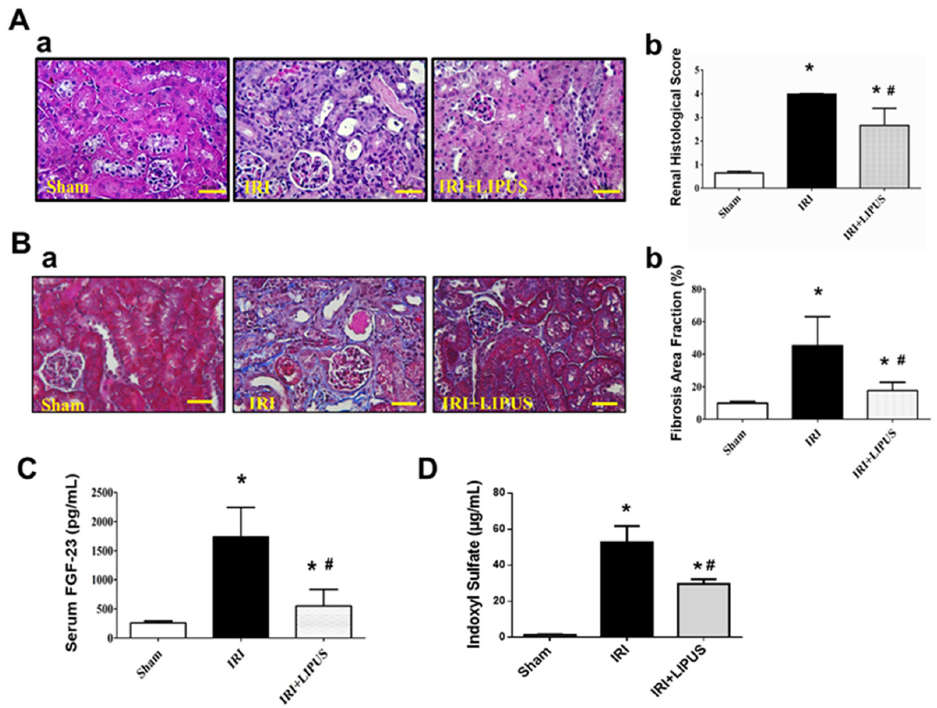
Figure 2. The effects of LIPUS on renal histology, renal fibrosis, and serum FGF-23 and indoxyl sulfate levels in IRI-CKD mice (the mice were euthanized 14 days after IRI): ( A ) ( a ) pathological changes in renal tissue sections stained with Periodic acid–Schiff (PAS), which were analyzed using a light microscope, and ( b ) histological score (scale bar: 50 μ m); ( B ) ( a ) renal collagen deposition stained by Masson’s trichrome and ( b ) quantifications (scale bar: 50 μ m); ( C ) serum FGF-23 levels; ( D ) serum indoxyl sulfate levels. Data are presented as mean ± SD (n = 8): * p < 0.05 versus the control group; # p < 0.05 versus the CKD-alone